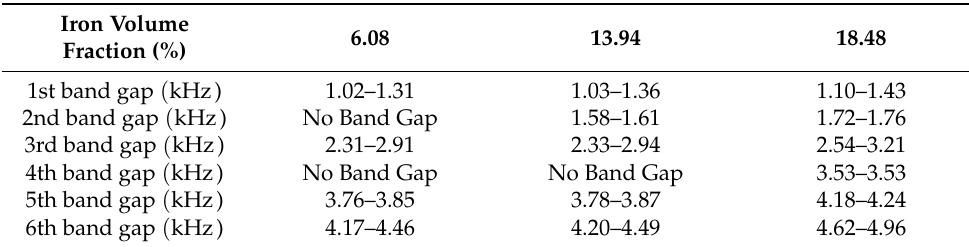
Table 3. Band gap areas for the modified unit cell with a cylindrical core of L / R = 8, and the arm angle of θ = − 1 ◦ in B = 75 mT.